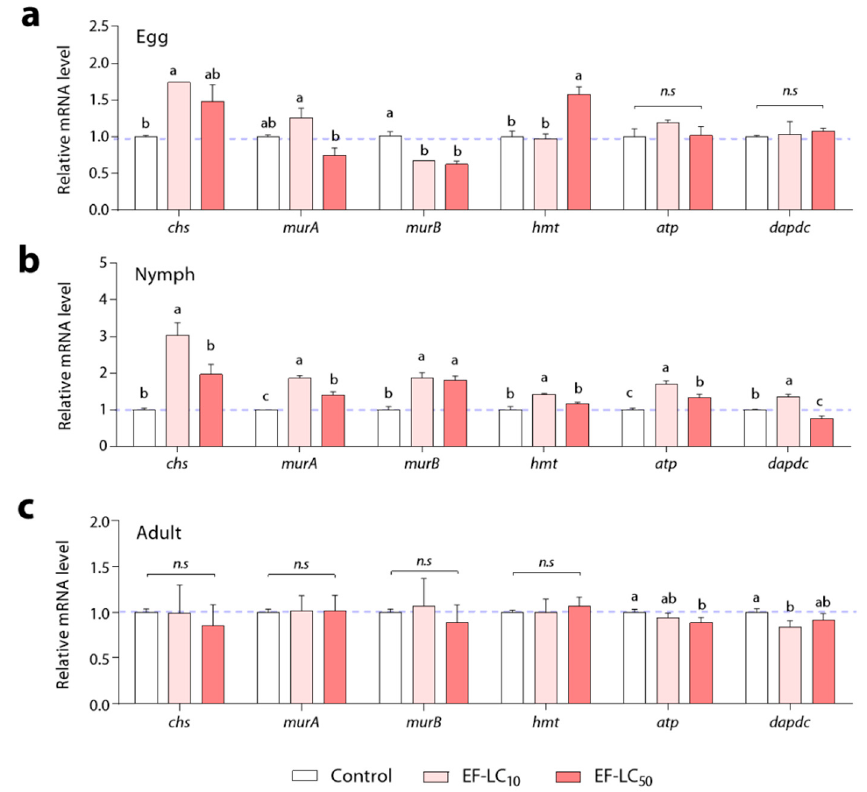
Figure 3. Gene expression levels of exposure to lethal concentration LC 10 and LC 50 values of ethyl formate (EF) for 4 h on P. citri developmental stages. Relative gene expressions of eggs ( a ), nymphs ( b ), and adults ( c ) were normalized using the expression level of glyceraldehyde-3-phosphate. Gene abbreviations were as follows: chitin synthase (chs), UDP-N-acetylglucosamine enolpyruvoyl transferase (murA), UDP-N-acetylenolpyruvoylglucosamine reductase (murB), homocysteine S-methyltransferase (hmt), V-ATPase (atp), and diaminopimelate decarboxylase (dapdc). Data were analyzed using one-way ANOVA, followed by post hoc Tukey’s tests. Different lowercase letters indicate significant differences among groups; a > b > c.